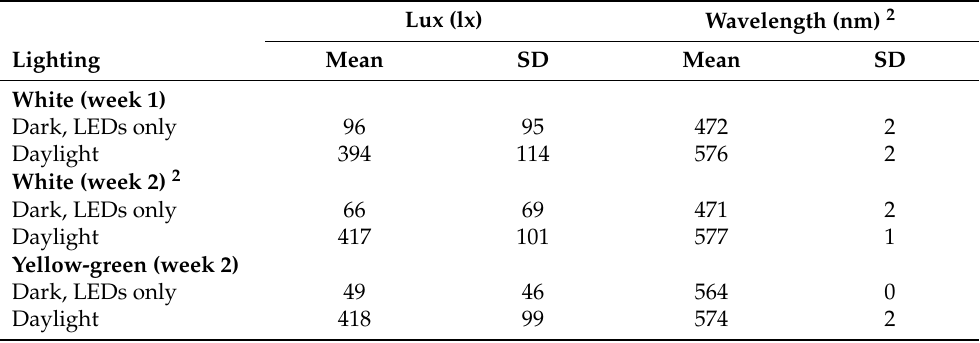
Table A1. Descriptive statistics of LED light illuminance (lux) and wavelength measured during two time periods: (1) when the facility was dark (no external light), and (2) during the daylight hours with LED and facility lights on. The average ( ± SD) of measurements taken in four places 1 per stall in all stalls ( n = 28) are